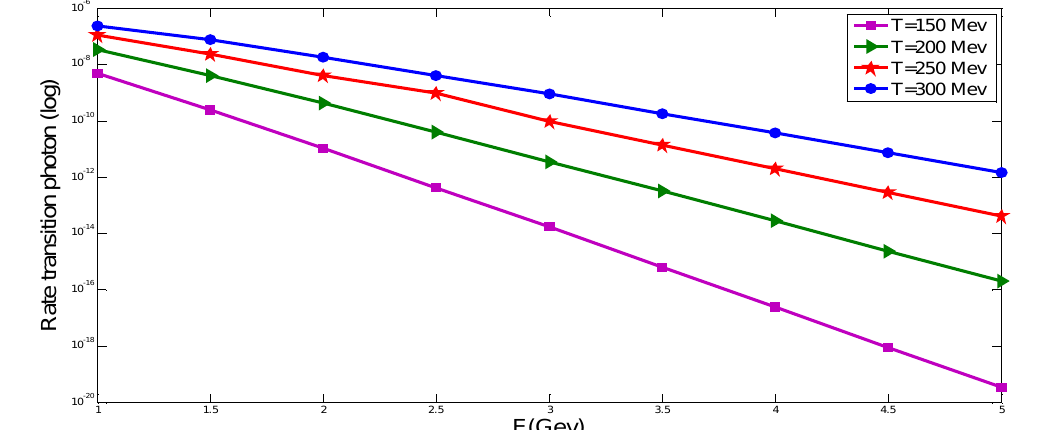
for (cid:2203)(cid:2189) → (cid:2186)(cid:2237) (cid:2172)(cid:2190)(cid:2197)(cid:2202)